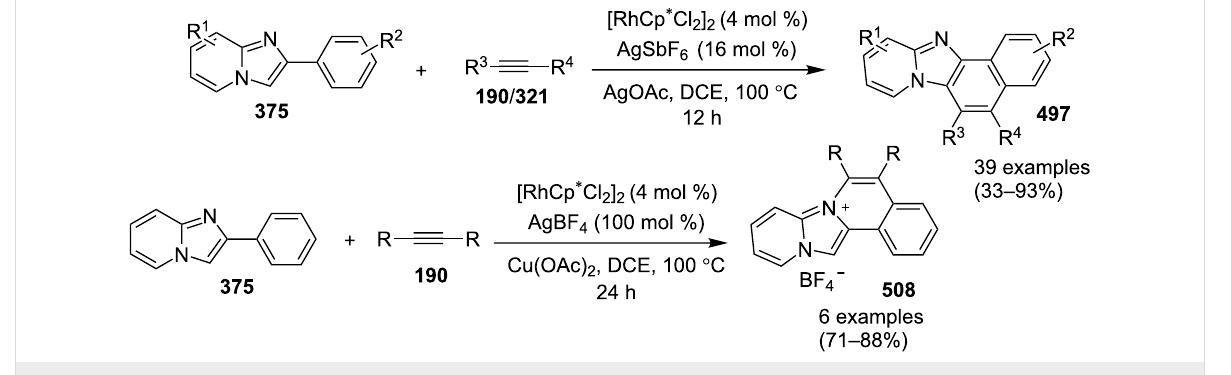
Scheme 177: Rh(III)-catalyzed C–H activation